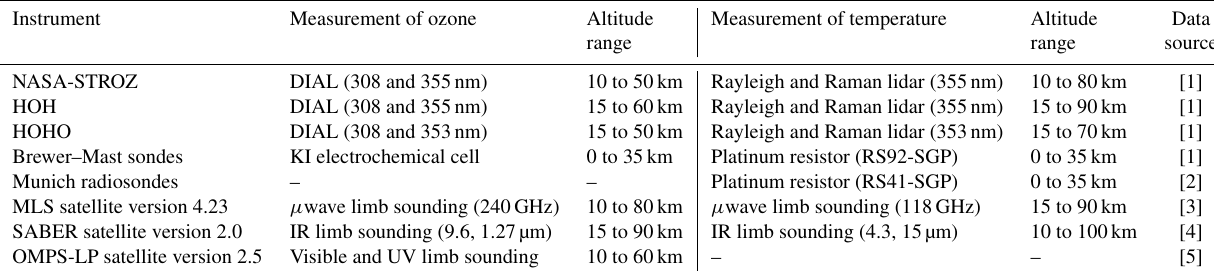
Table 3. Instruments compared during the HOPS campaign in October 2018 and March/April 2019.